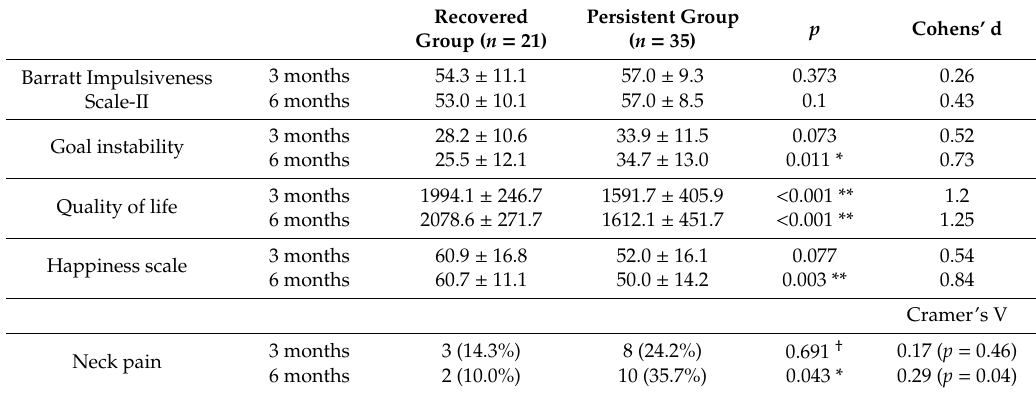
Table 3. Follow-up findings of the recovered and persistent groups.